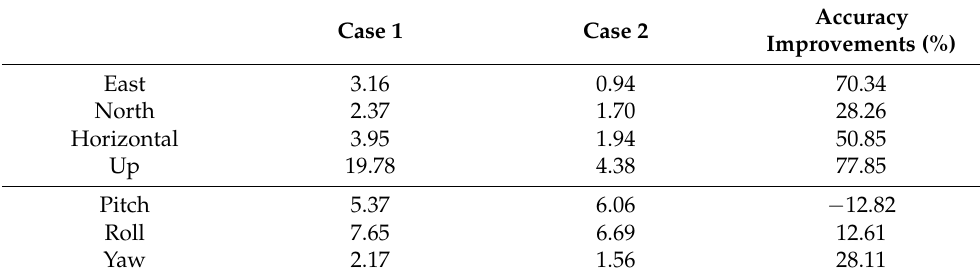
Table 4. Performance comparison between the two study cases (RMSE improvement).